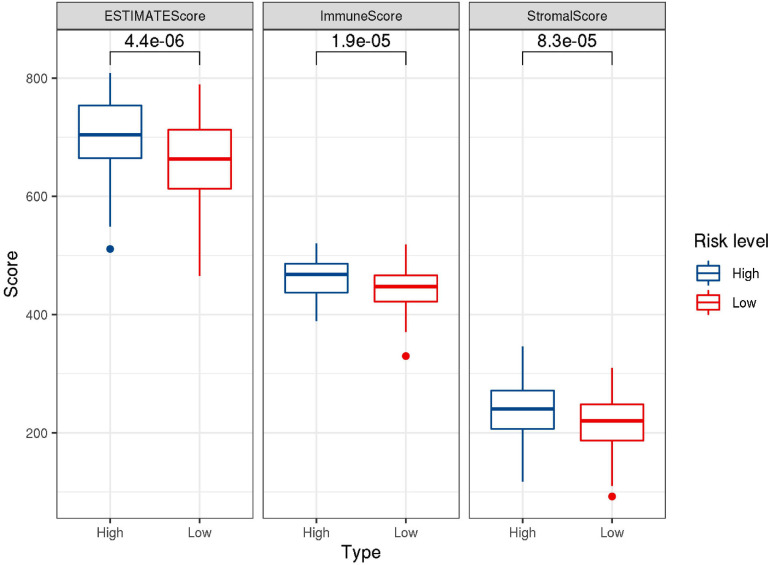
Box-plots showed the difference in the scores of ESTIMATE, immune and stromal between the low- and high-risk groups.